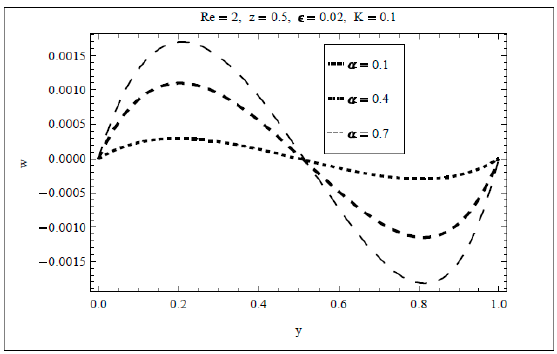
Figure 8. Effect of α on cross-flow velocity w along y . Coatings 2019 , 9 , x FOR PEER REVIEW Figure 8. E ff ect of α on cross-flow velocity w along y .